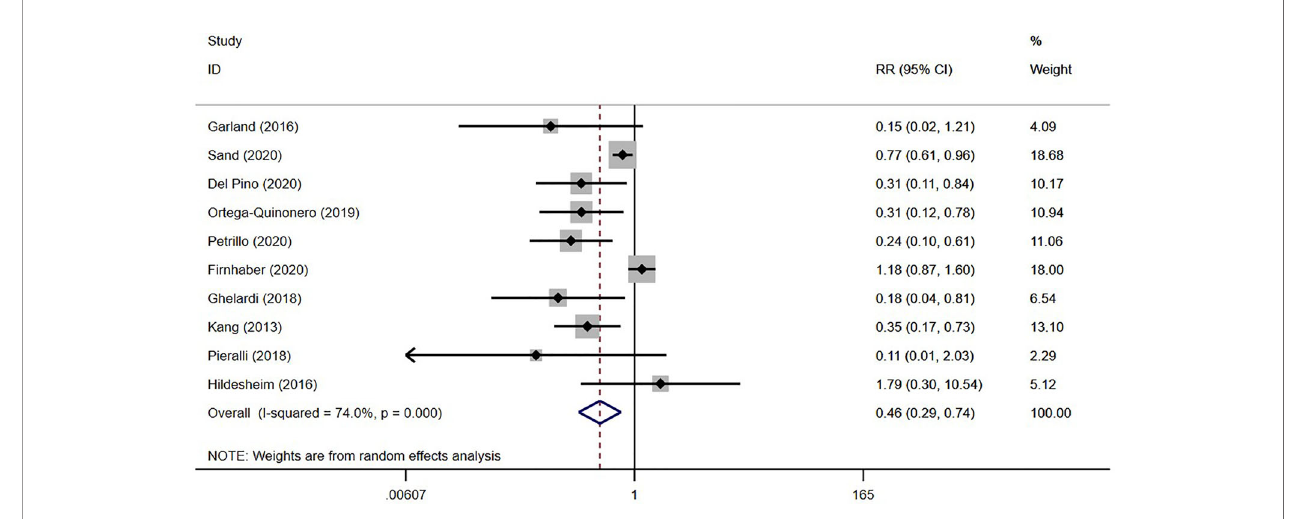
FIGURE 2 | Forest plot for preventing recurrence of HSIL.